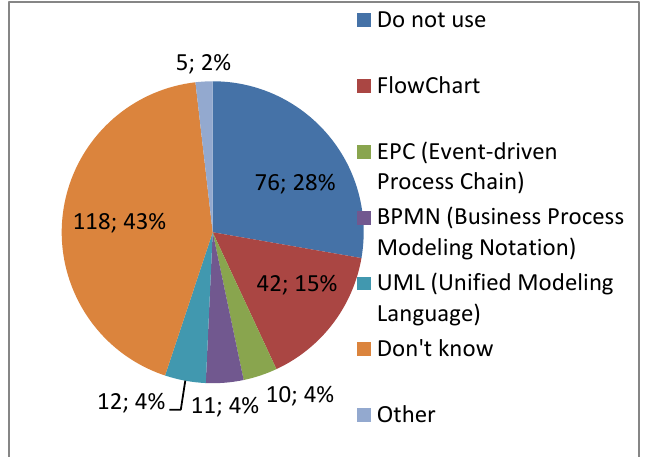
Fig. 3. BP modeling method used by